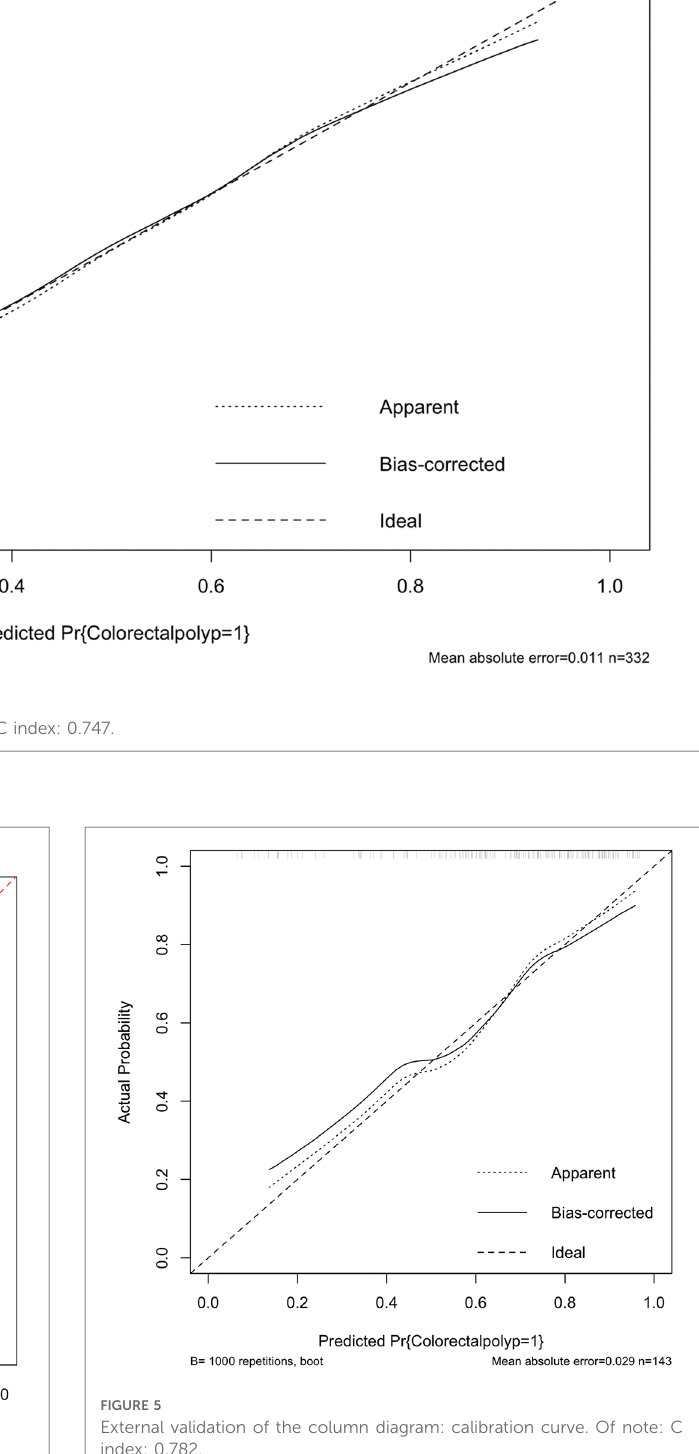
FIGURE 4 External validation of the column diagram: ROC. Of note: AUC: 0.782; 95% CI: 0.703-0.861; p <0.001.